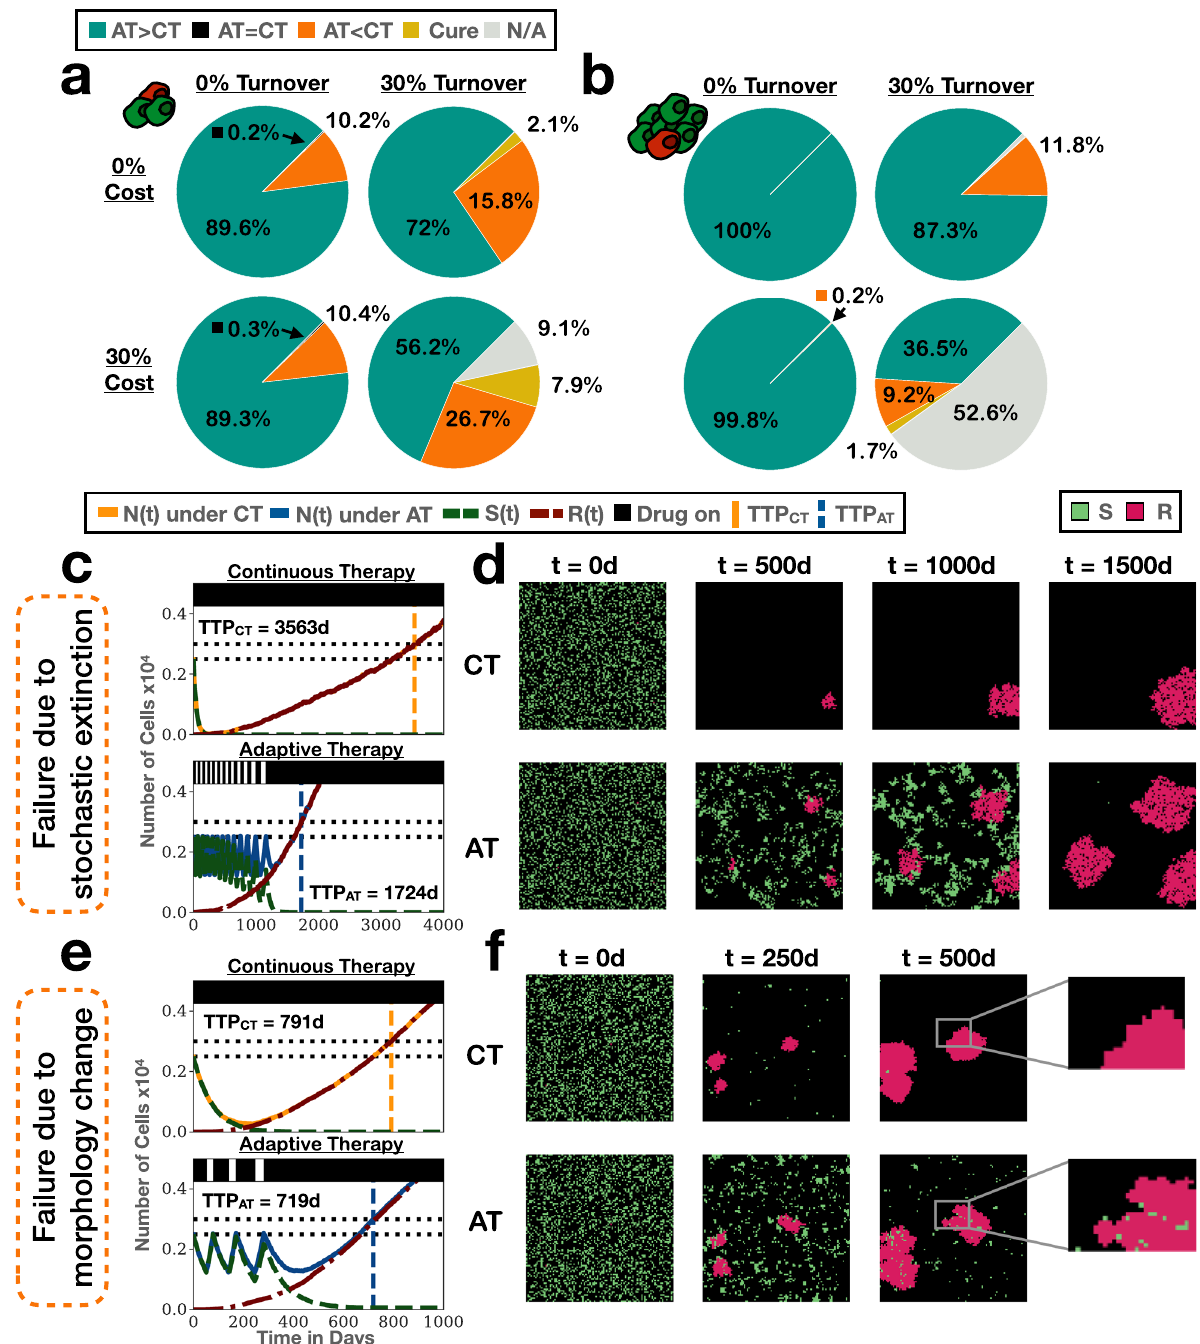
Fig. 6 While adaptive therapy is bene fi cial on average, stochastic and spatial effects can result in inferior outcomes in a subgroup of simulations in the ABM. AT: adaptive therapy, CT: continuous therapy, TTP: time to progression, TTP CT : TTP under CT, TTP AT : TTP under AT, ABM: agent-based model. a Distribution of outcomes for different values of cost and turnover for an initial tumour composition of ( n 0 , f R ) = (25%,0.1%) ( n = 1000 replicates per condition). This shows that while cures are rare, in a number of cases longer tumour control is achieved by continuous therapy. “ N/A ” denotes that the tumour had neither progressed nor been cured within the 10 year simulation time frame. b Outcome distributions for the same conditions as a but with a higher initial celldensity(( n 0 , f R ) = (50%, 0.1%); n = 1000replicates per condition). Inferior resultsfor adaptive therapy becomerarer,indicating a stochasticoriginofthese failures. c Treatment trajectories for the case with the worst outcome for adaptive therapy in a (( n 0 , f R , c R , d T ) = (25%, 0.1%,30%,30%); n = 1 replicate). d Simulation snapshots corresponding to c , showing that continuous therapy in this case progresses more slowly because all but one resistant nest goes extinct. e Treatment trajectories for the case with the worst outcome for adaptive therapy in a , but in the absence of turnover or cost (( n 0 , f R , c R , d T ) = (25%,0.1%,0%,0%); n = 1 replicate). f Simulation snapshots corresponding to e , suggesting that in this case the branching pattern induced by competition during adaptive therapy is the reason for faster progression (see also Supplementary Fig. 9b for further